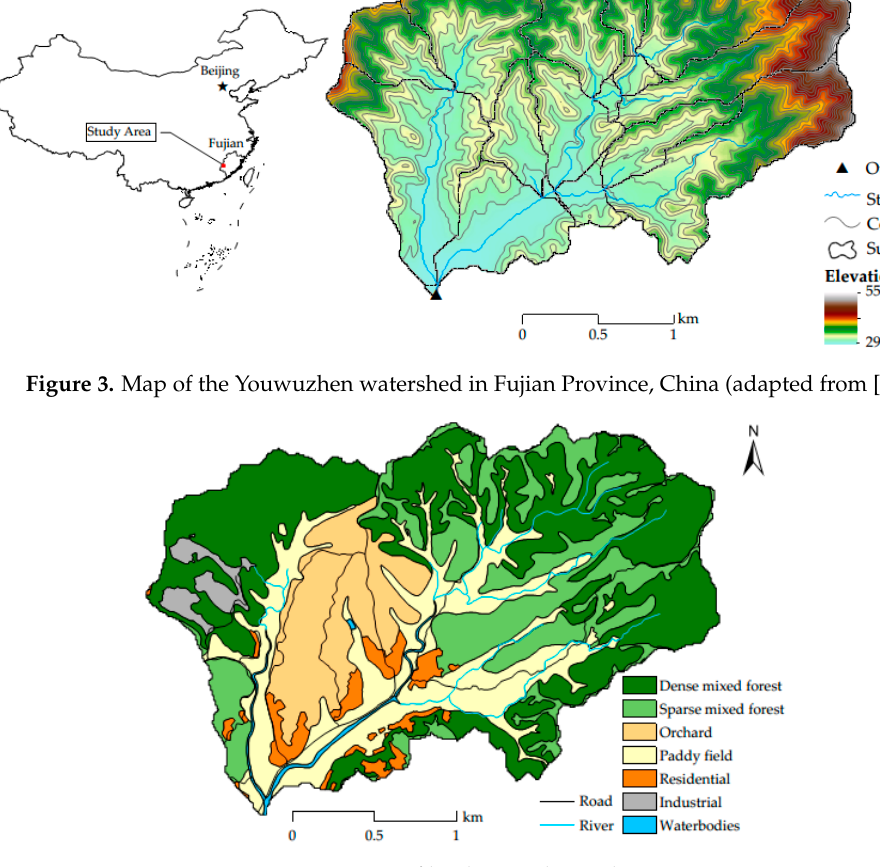
Figure 4. Map of landuse in the study area.